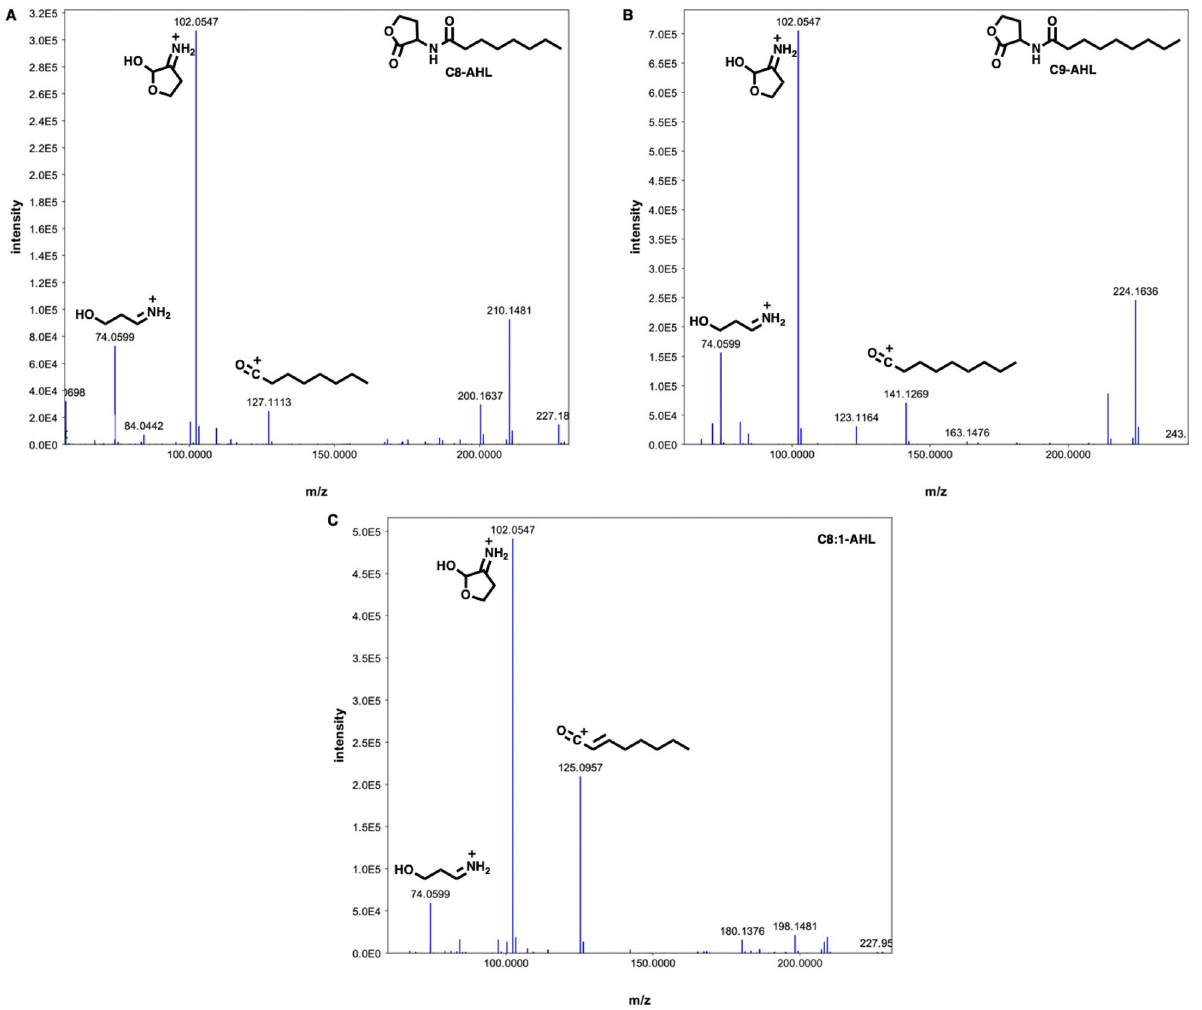
Figure 4. MS/MS fragmentation spectra with diagnostic fragments indicated for each AHL detected in extracts from heterologous E. coli expressing